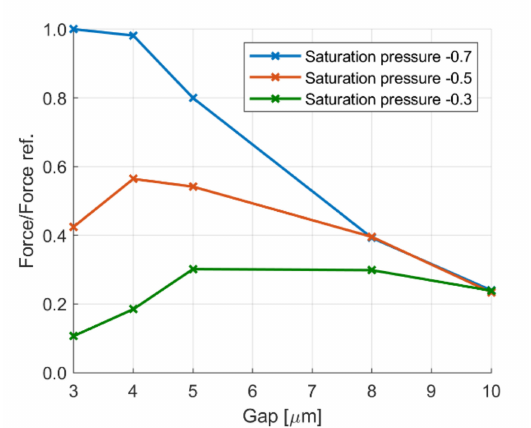
Figure 20. Bearing capacity is generated by a partial texturing configuration. Influence of the gap for di ff erent values of saturation pressure. Set A cavitation coe ffi cients. Square dimple with side 50 µ m and depth 10 µ m, sliding velocity 10 m /